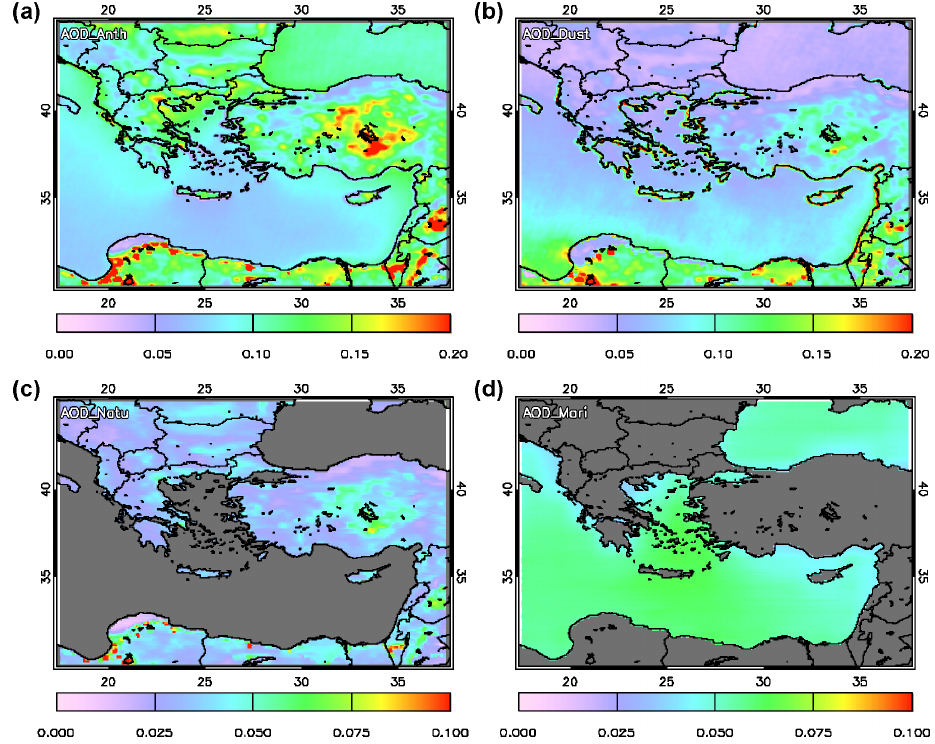
Figure 8. (a) Anthropogenic aerosol ( τ a ) , (b) dust ( τ d ) , (c) fine-mode natural aerosol ( τ n ) and (d) marine aerosol ( τ m ) patterns over the Eastern Mediterranean based on MODIS Terra observations during the period March 2000–December 2012 (March 2000–December 2007 for regions of northern Africa covered by DB data